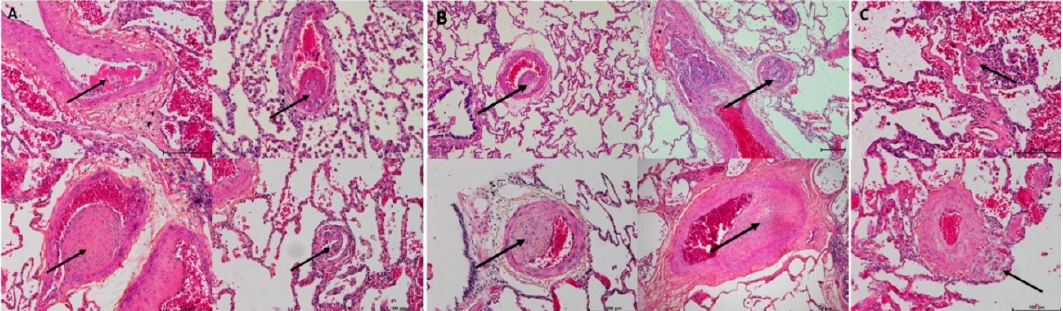
Figure 10 . Histopathology of different patterns of thrombi for the 3 stages of angiophagy in patients with CTEPH. ( A ) (Stage I): In the left upper panel, a recent thrombus of fibrin is poorly cellularized; in the right upper panel, the thrombus seems adherent to the media and is surrounded by endothelial cells with few cells inside the thrombus; in the left lower panel, the thrombus is, importantly, cellularized with a low rate of fresh fibrin, which reflects an aspect of fibrinous evolution; in the right lower panel, the thrombus seems entirely cellularized without fibrin or fibrosis. ( B ) (Stage II): The different patterns of thrombi were cellularized thrombi without fibrosis (left and right upper panels) and cellularized thrombi with fibrosis (left and right lower panels). ( C ) (Stage III). The thrombus is located outside the pulmonary artery (arrow) and is poorly cellularized (upper panel); the thrombus is located outside the pulmonary artery (arrow) and is cellularized (lower panel). Hematein–eosin– saffron staining.